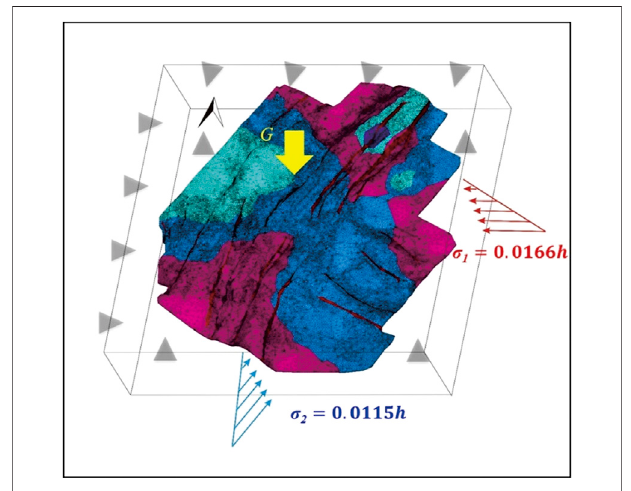
FIGURE 2 | The boundary conditions of geo-stress in the second member of Jialingjiang formation, Puguang area.